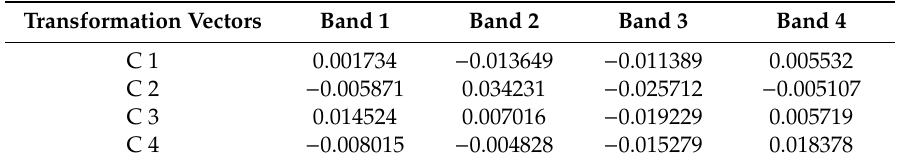
Table 6. Transformation vectors of MNF analysis on a spectral subset of the ASTER data for detecting the argillic alteration zones in the study area.